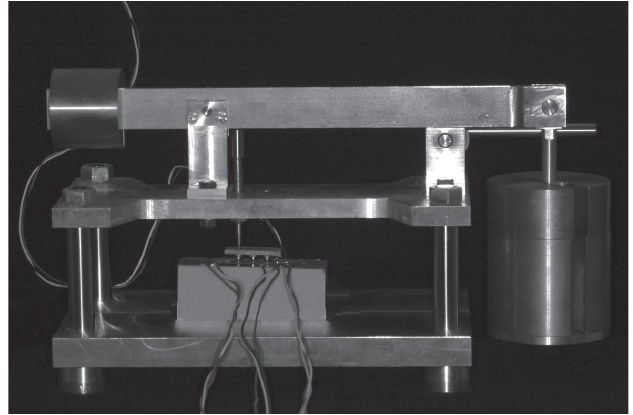
Fig. 3 - Experimental model in the loading apparatus with load applied at point